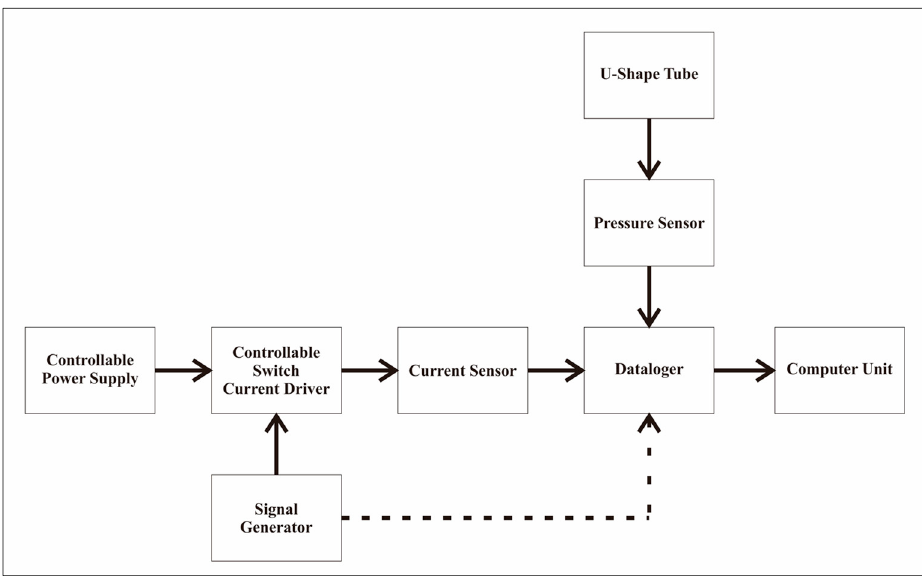
Figure 2. A schematic block-diagram for pressure measurement.